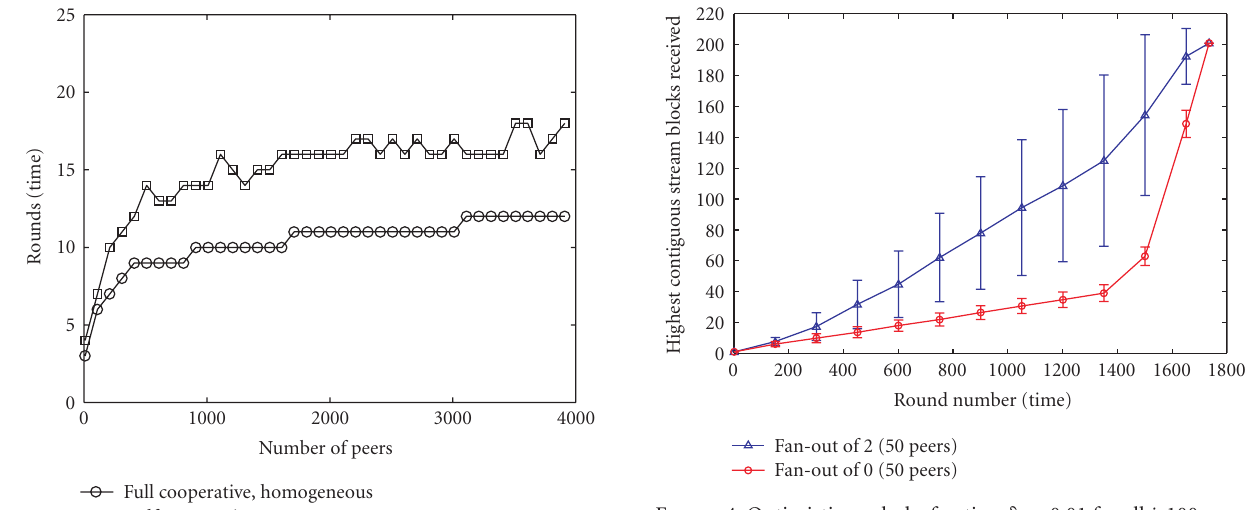
Figure 4: Optimistic unchoke fraction δ i = 0 . 01 for all i , 100 peers, 100 stream